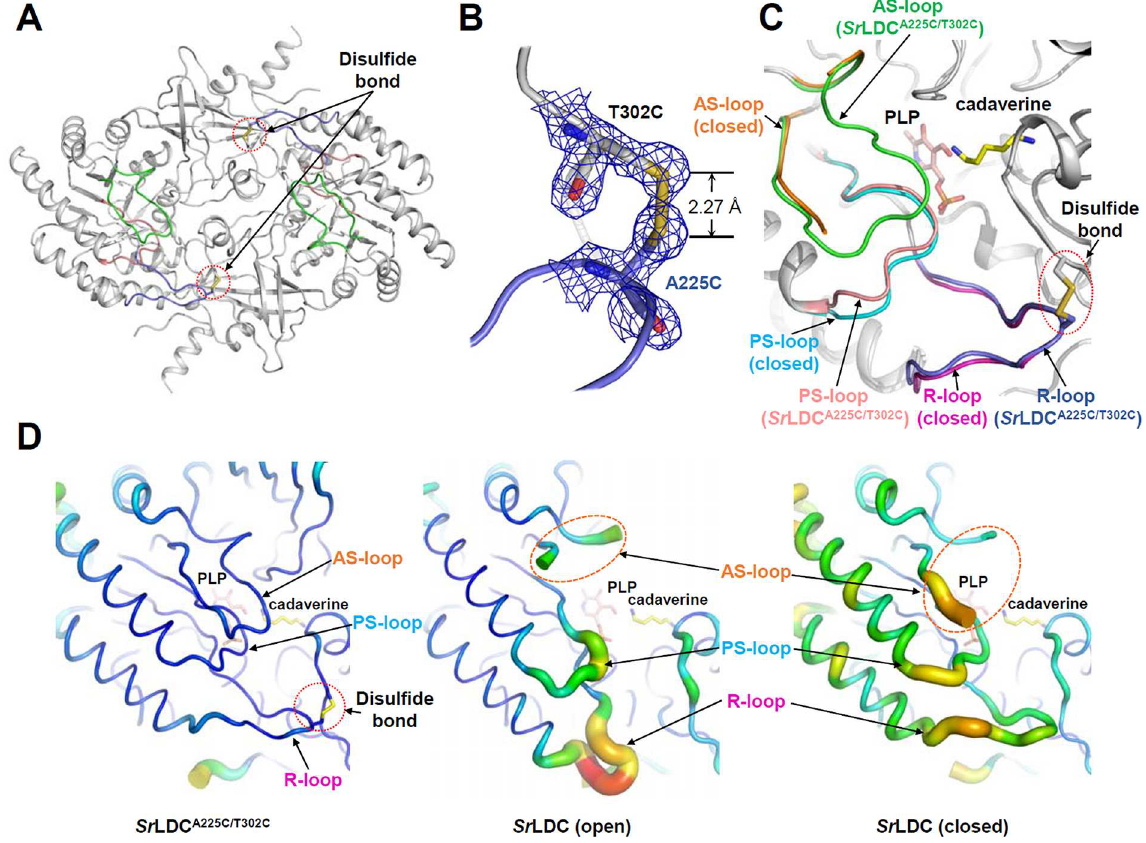
Fig 5. Crystal structureof the Sr LDC A225C/T302C mutant. ( A )Dimeric structure of the Sr LDC A225C/T302C mutant. The AS-loop,PS- loopand the R-loopof the Sr LDC A225C/T302C mutant are coloredgreen, salmon, and light-blue,respectively. The disulfidebondformed in both monomersare indicatedare shown as stick modeland labeled.( B )Electron density map of the engineered disulfidebond region.The Fo-Fc map of the engineereddisulfidebondregionis contouredat 3.0 σ . The R-loopregionis presented with a light-blue color and the mutated residuesare shown as stick modelswith labels.( C )Superimpositionof the Sr LDC A225C/T302C structure with the closedform of Sr LDC.The AS-loop,the PS-loop, and the R-loopof the Sr LDC A225C/T302C mutant are distinguishedwith colors of green, salmon, and light-blue,respectively, and those of the closedform of Sr LDCare with colors of orange,cyan, and magenta,respectively. ( D )B-factor presentationof the Sr LDC A225C/T302C mutant and Sr LDCin apo and complexwith PLP/cadaverine. The AS-loop,the PS- loop,and the R-loopare